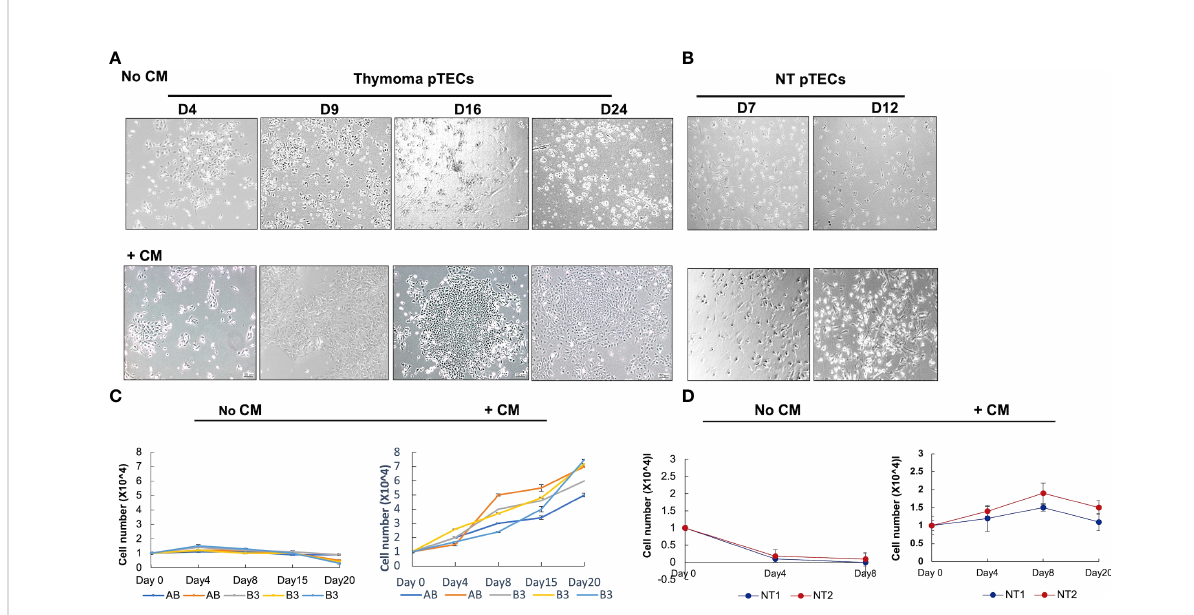
FIGURE 4 Effect of conditioned medium (CM) on primary thymic epithelial cells (pTECs) derived from thymomas and normal adult thymuses. Thymoma and normal thymus-derived pTECs were seeded in the presence of neoplastic thymic tumor conditioned media (CM) or the control standard medium (RPMI/Hepes/FBS) in 96-well plates. (A) : representative images of B3 thymoma-derived pTECs cultured from 4 to 24 days in the absence or presence of CM; (B) : representative images of normal thymus-derived pTECs from 7 to 12 days in the absence or presence of CM; (C, D) : Cell proliferation measured using MTT assay after culturing AB and B3 thymoma-derived pTECs (C) and NT-derived pTECs (D) with and without CM. No CM, without conditioned medium. Triplicate measurements of MTT were performed of two independent experiments. FBS, fetal bovine